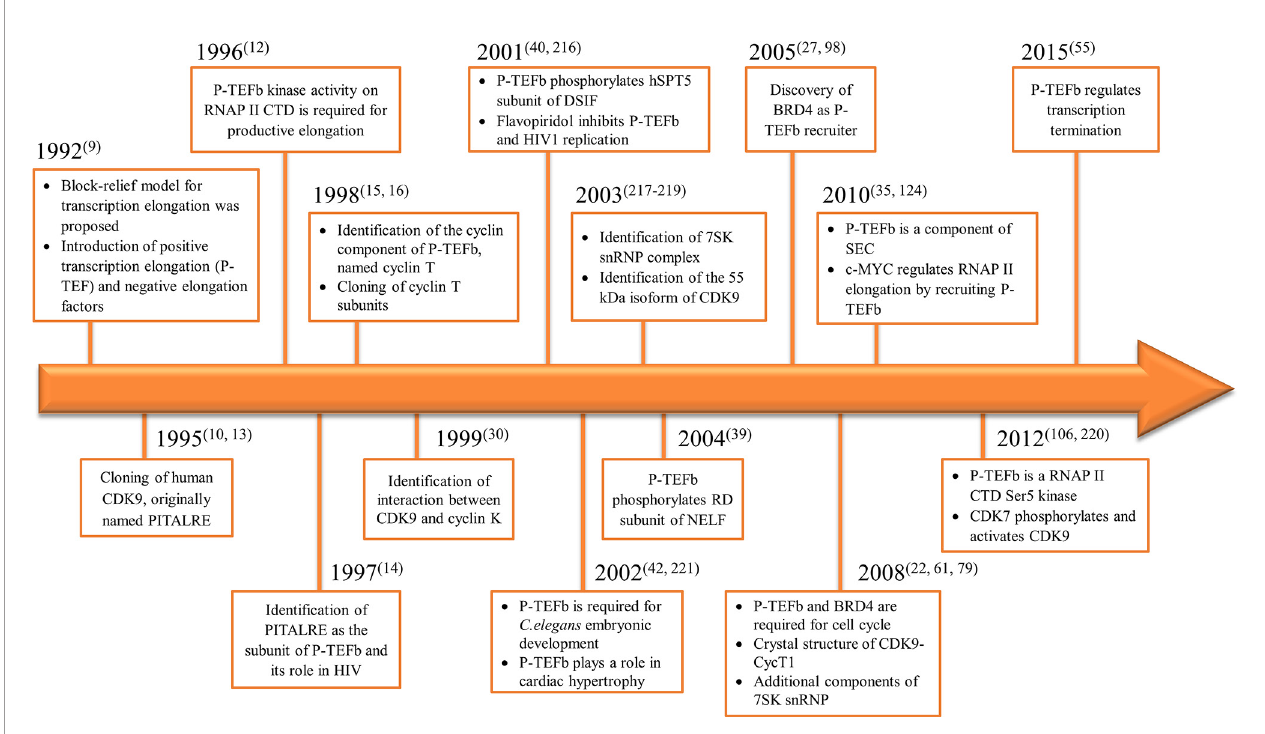
FIGURE 1 | Timeline for the discovery of P-TEFb and its biological